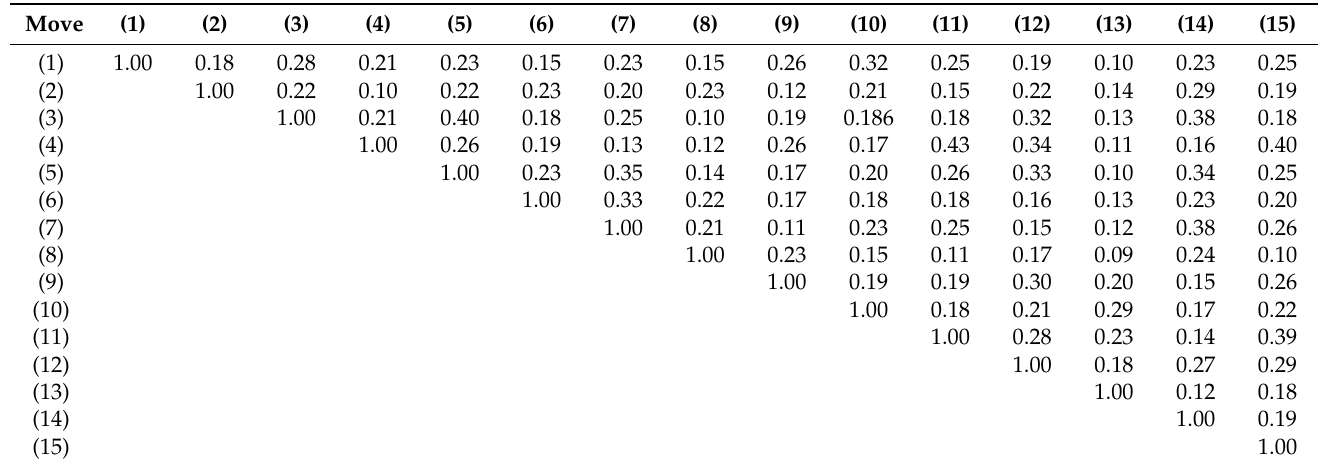
Table 2. Solo jazz template moves’ pairwise similarities calculated using the 3D projections of the acceleration and angular velocity. Depicted in red are the highest similarities obtained for each move, excluding self-similarity.